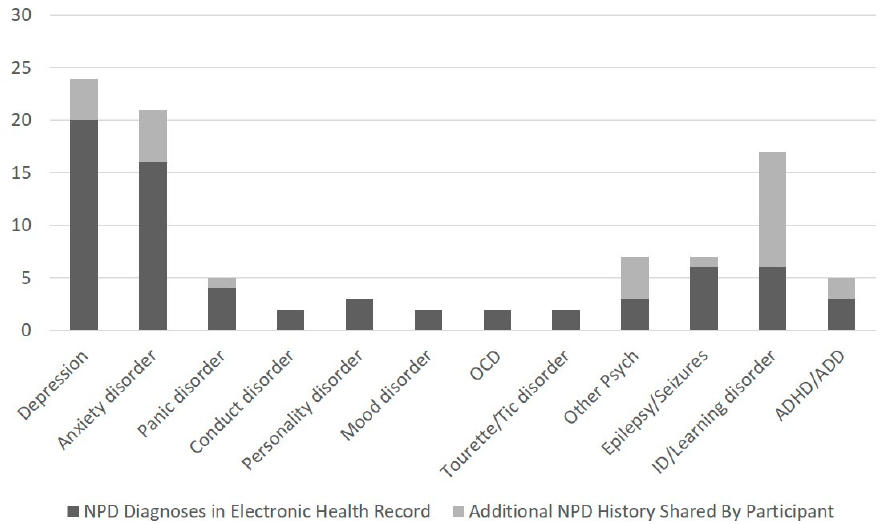
Figure 1. Neurodevelopmental/psychiatric diagnoses there were documented in participants’ electronic health record (EHR) versus participant reported diagnoses that were absent from the EHR. NPD - neurodevelopmental/psychiatric disorder; OCD - obsessive compulsive disorder; ID – intel- lectual disability; ADHD – attention deficit hyperactivity disorder; ADD – attention deficit disor- der